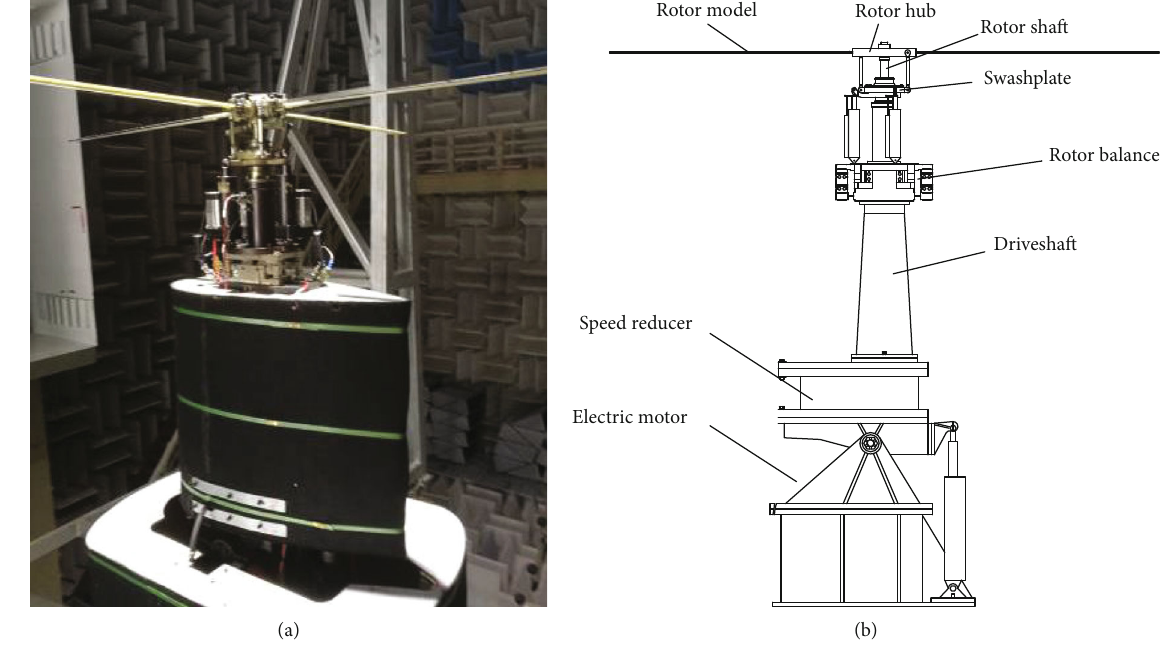
Figure 2: (a) Rotor test stand and (b) its technical